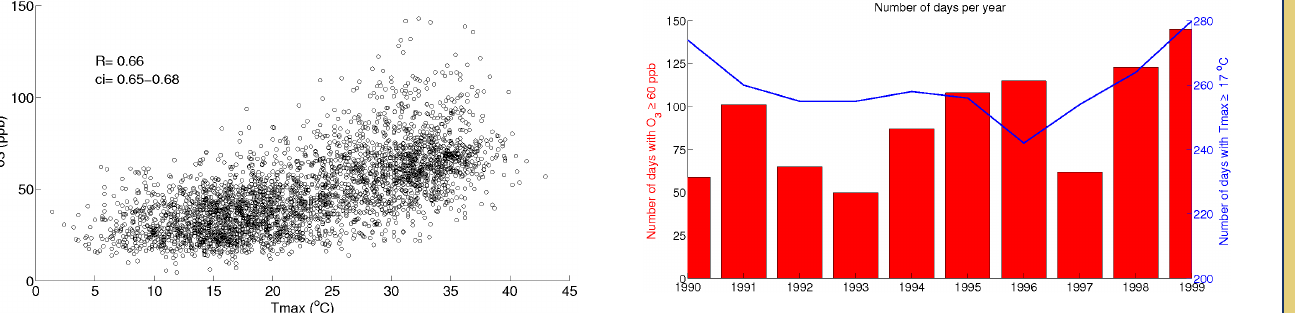
Figure 2. Correlation coefficient R and limits of the 95% confidence interval, ci, as calculated by bootstrap between maximum 8-h average ozone concentration and daily maximum temperature.